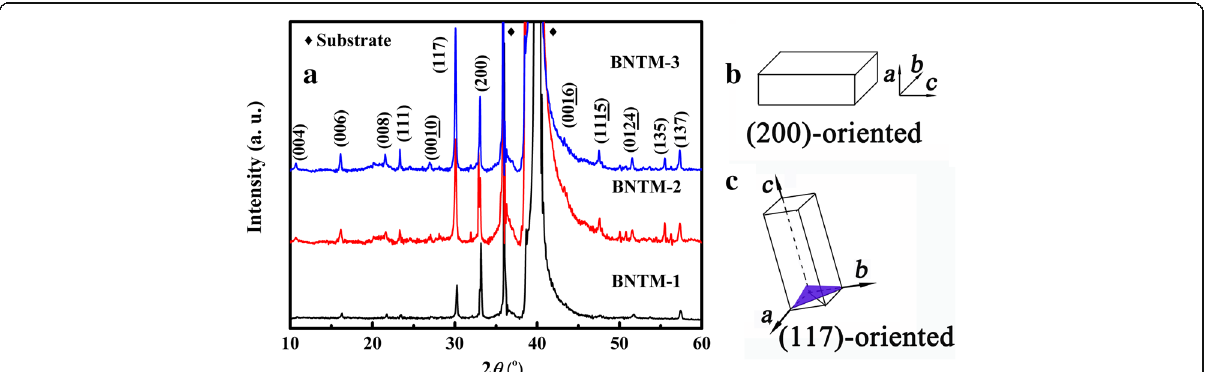
Fig. 1. XRD patterns of BNTM-1, BNTM-2, and BNTM-3 thin films ( a ) and schematic diagram of (200)-grain growth ( b ) and (117)-grain growth of thin films ( c )